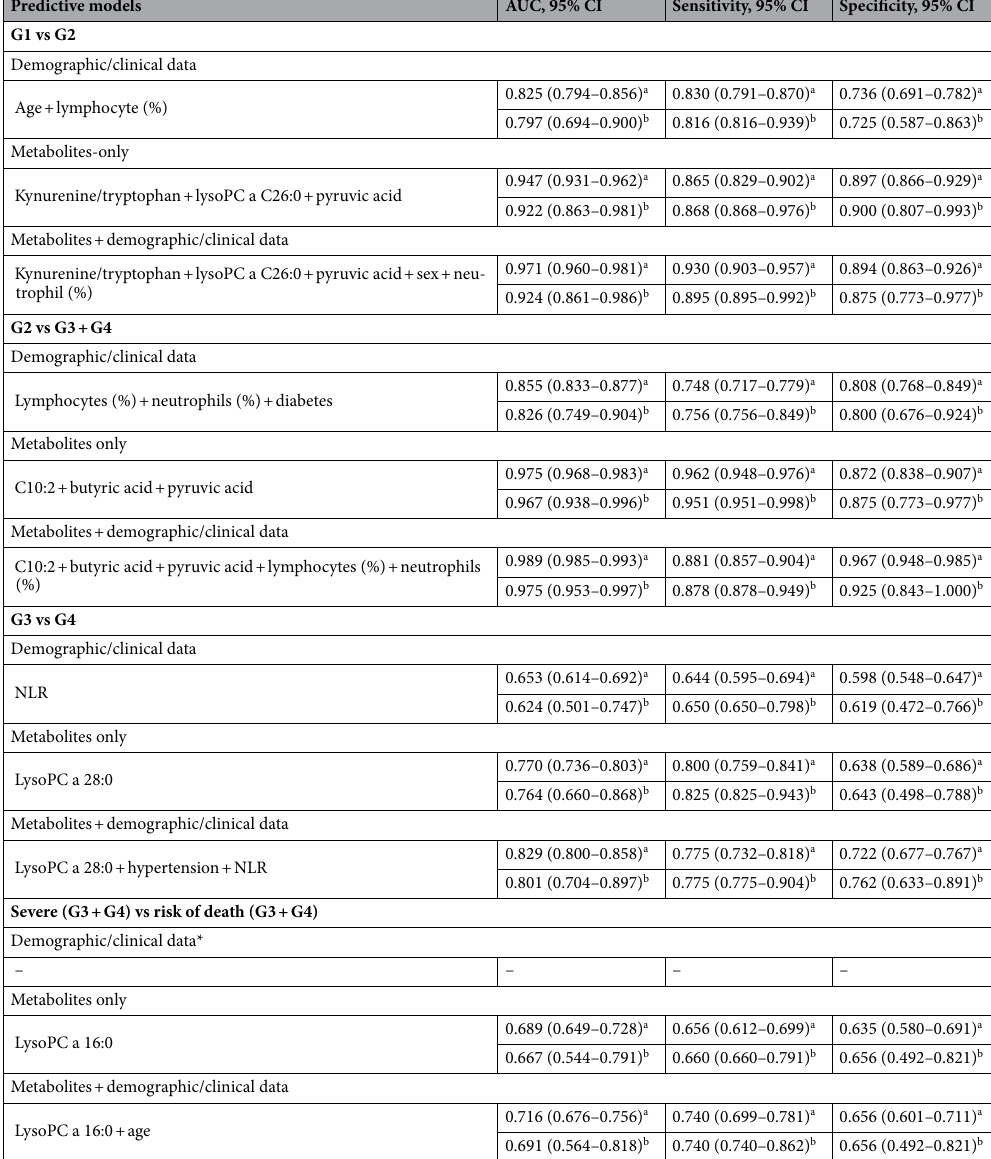
Table 2. The AUC, Sensitivity and Specificity with 95% confidence intervals (CI) of each predictive panel of plasma metabolites (metabolites-only and metabolites plus demographic/clinical data models) for COVID- 19. G1: PCR−, controls, G2: PCR+, not hospitalized; G3: PCR+, hospitalized, G4: PCR+, intubated, G3 + G4: severe patients. *Variables were not significant to be included in the